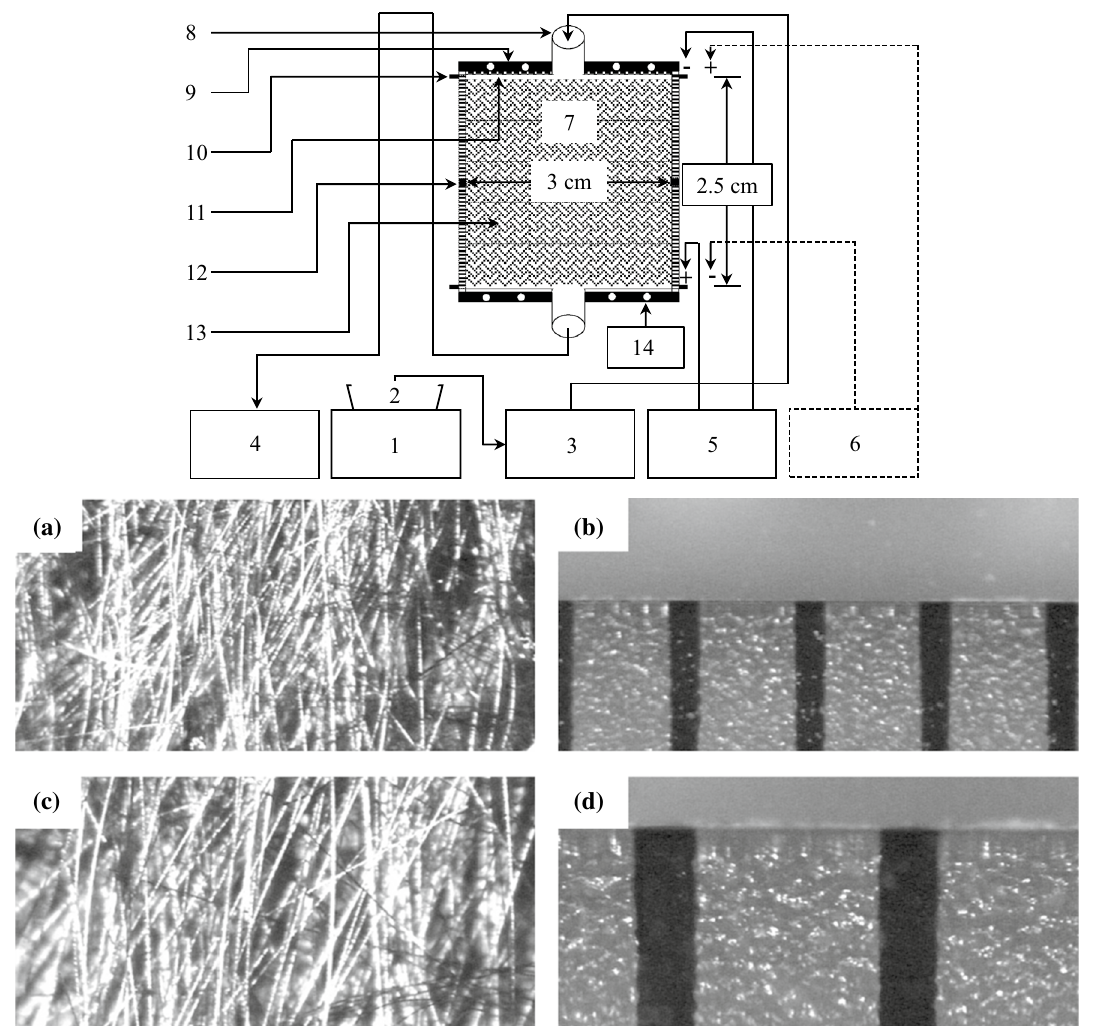
Fig. 2 Laboratory-scale experimental setup. 1: ultrasonic cleaner, 2: influent, 3: feed water pump, 4: effluent, 5: DC power supply in filtration mode, 6: DC power supply in back-washing mode, 7: filter module, 8: acrylic tube, 9: acrylic resin cover, 10: porous stainless steel plate, 11: polytetrafluoroethylene mesh, 12: silicon rubber, 13: carbon fiber felt, and 14: bolts. a Picture of the carbon fiber felt with